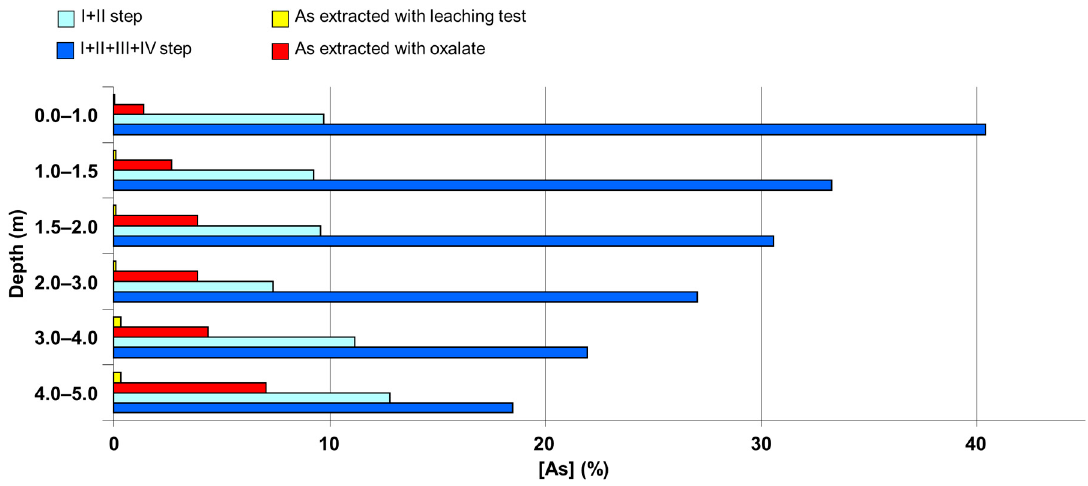
Figure 6. Comparison between the average percentage of As extracted for the leaching test, by ammonium oxalate, and in the first two steps and the first four steps of sequential extraction procedures for soil samples, in all the sampled levels of depth.